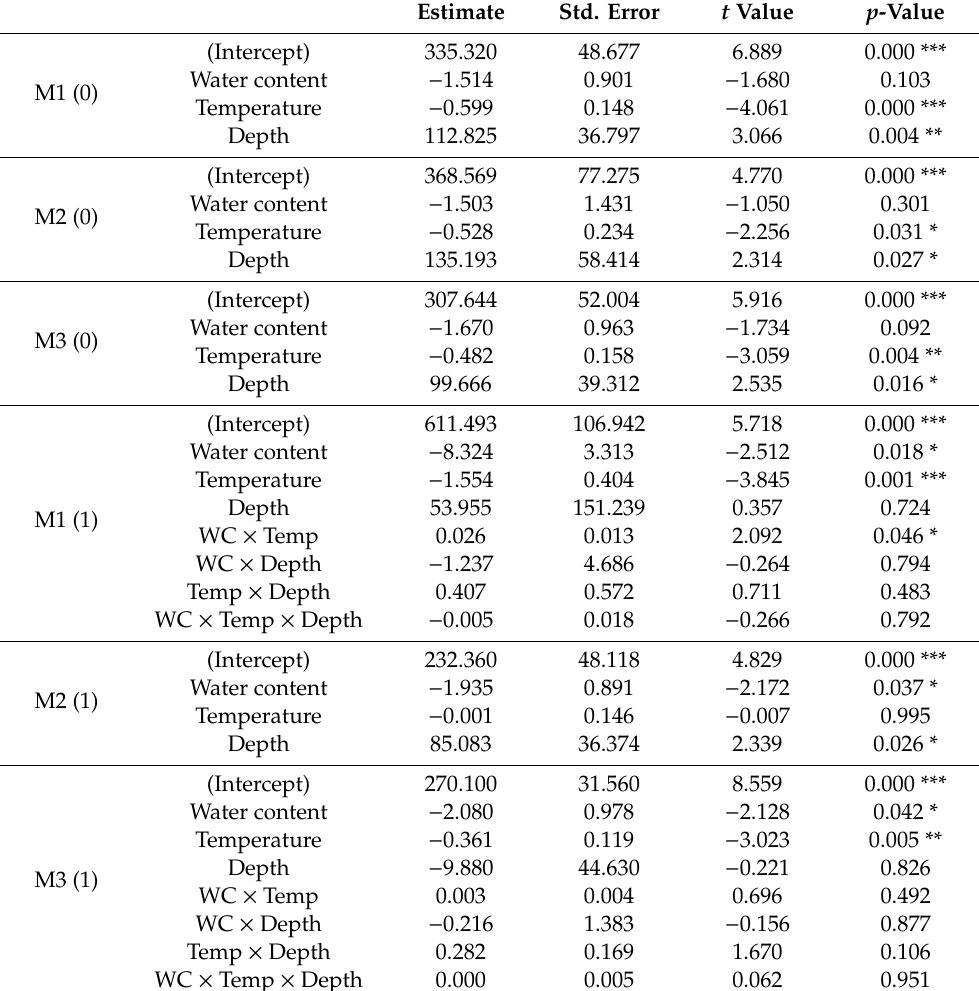
Table 5. Results of GLM performed with the total biomass data obtained immediately (0) and one (1) month after the heating in the three di ff erent soil mixtures (M1, M2 and M3). Significance